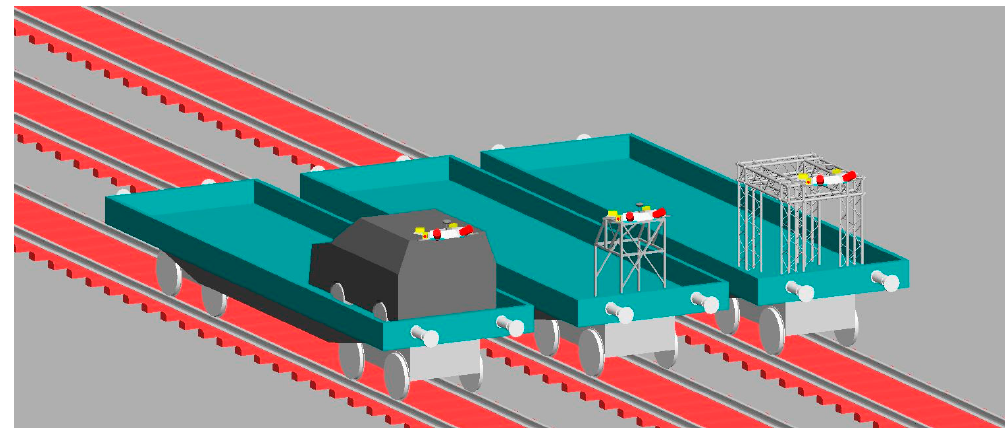
Figure 13. Models of mounting MMS on open rail cars used during surveys. Left RIEGL VMX-250 survey in 2011, center RIEGL VMX-250 survey in 2012, right VMX-450 survey in 2012.